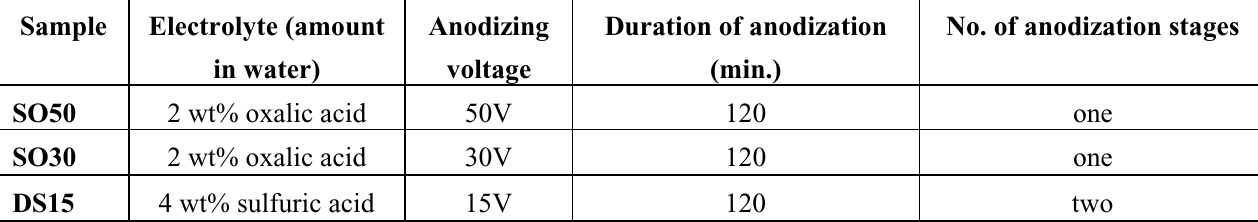
Table 1. Anodization conditions used for making nanoporous alumina